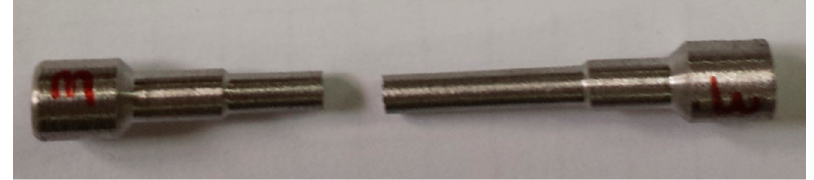
Figure 10. Sample THA-1 with THA-3 fractured in the zone distant from the joint line material THA-3.